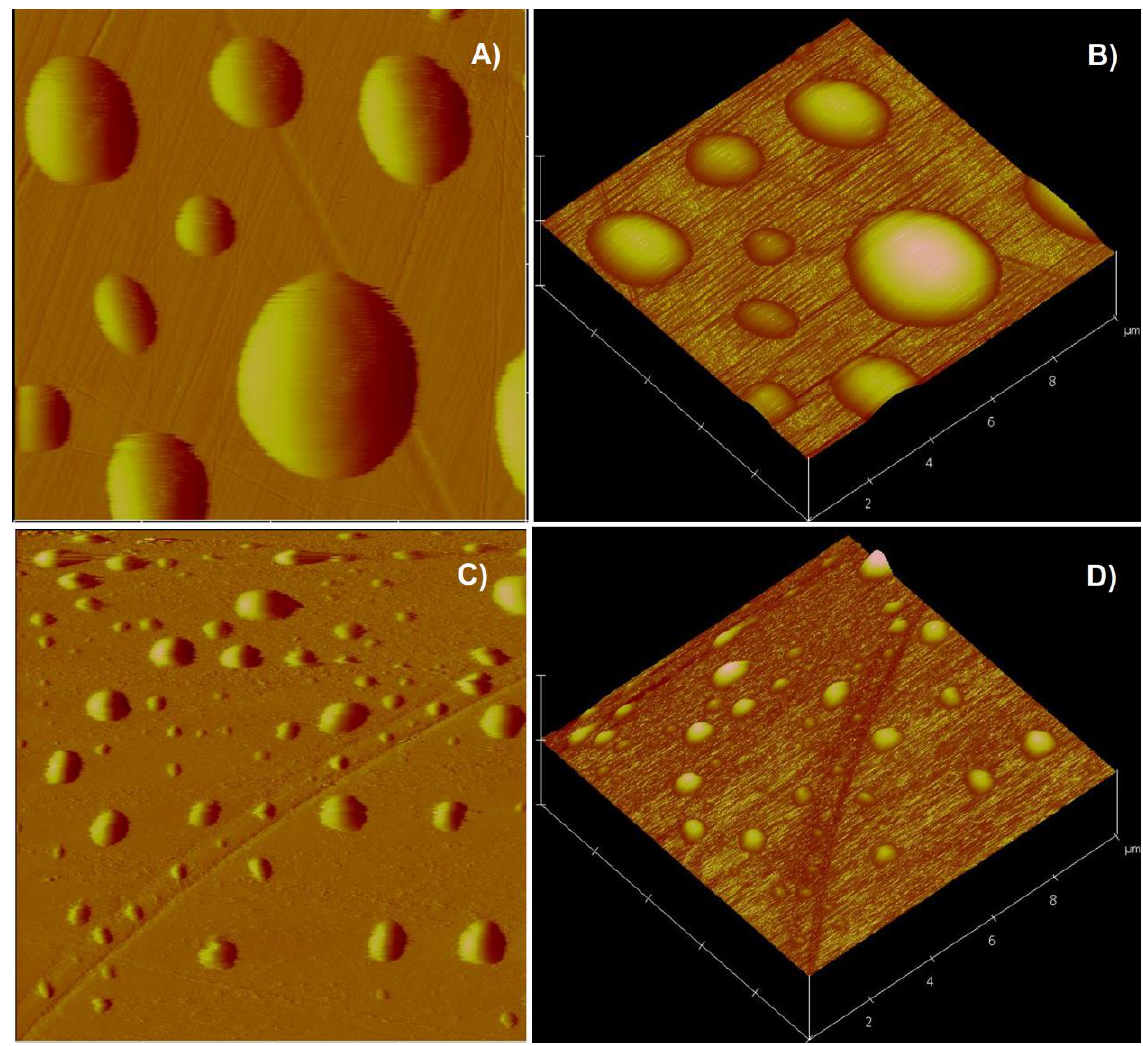
Figure 14. AFM images of a chalcopyrite surface in the xanthate solution at pH 6 for 30 min. ( A ) The 10 µm × 10 µm deflection image with a data scale of 200 nm at 5 × 10 − 4 M KEX, ( B ) the 3D image of ( A ), ( C ) the 10 µm × 10 µm deflection image with a data scale of 200 nm at 5 × 10 − 5 M PAX and ( D ) the 3D image of ( C ).